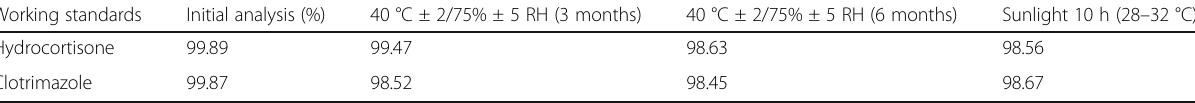
Table 3 Stress study of hydrocortisone and clotrimazole assay for experimental topical cream at 40 °C temperature and sunlight Working